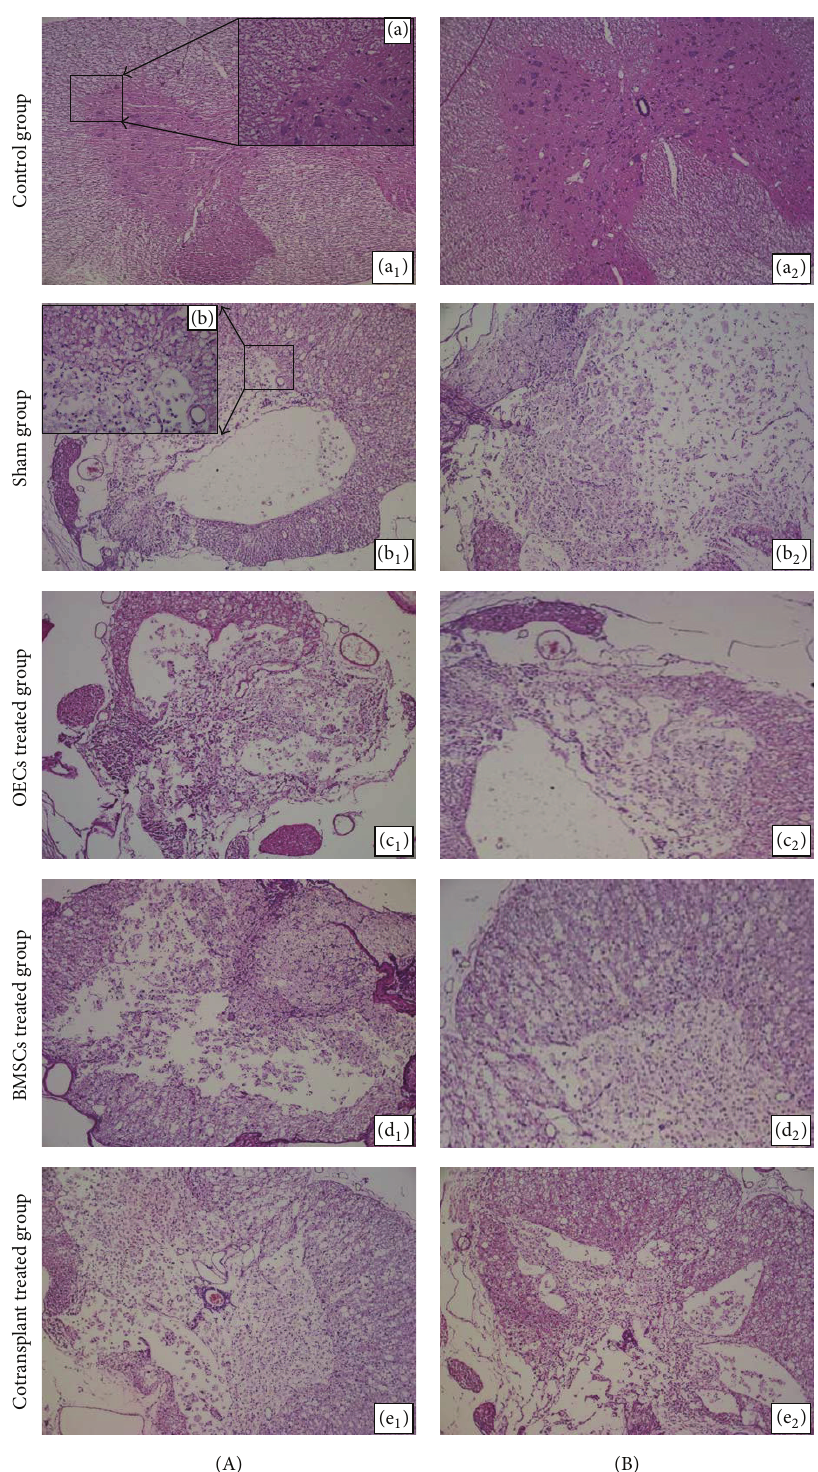
Figure 4: H&E staining of spinal cord tissue in each group. (A) 14 days after transplantation; (B) 28 days after transplantation: (a 1 , a 2 ) control group; (b 1 , b 2 ) sham group; (c 1 , c 2 ) OECs treated group; (d 1 , d 2 ) BMSCs treated group; (e 1 , e 2 ) cotransplant treated